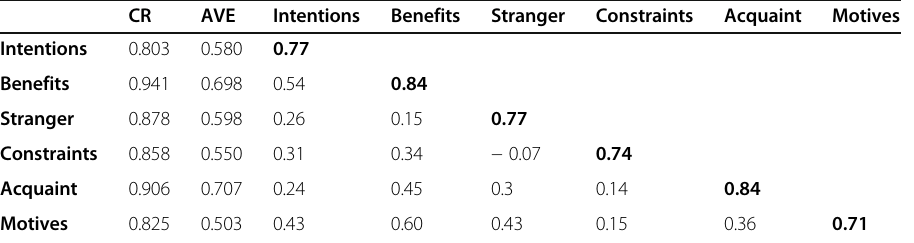
Table 4 Test results of convergent and discriminant